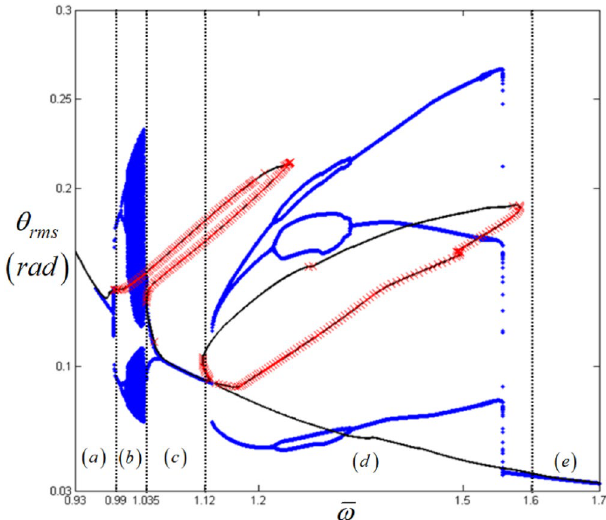
Figure 12. Comparison of HBM and bifurcation diagram with RMS values focused on sub-harmonic resonances with the initial condition path (B): Key: Black line, HBM result with stable condition; Red times , HBM result with unstable condition; Blue circle, bifurcation